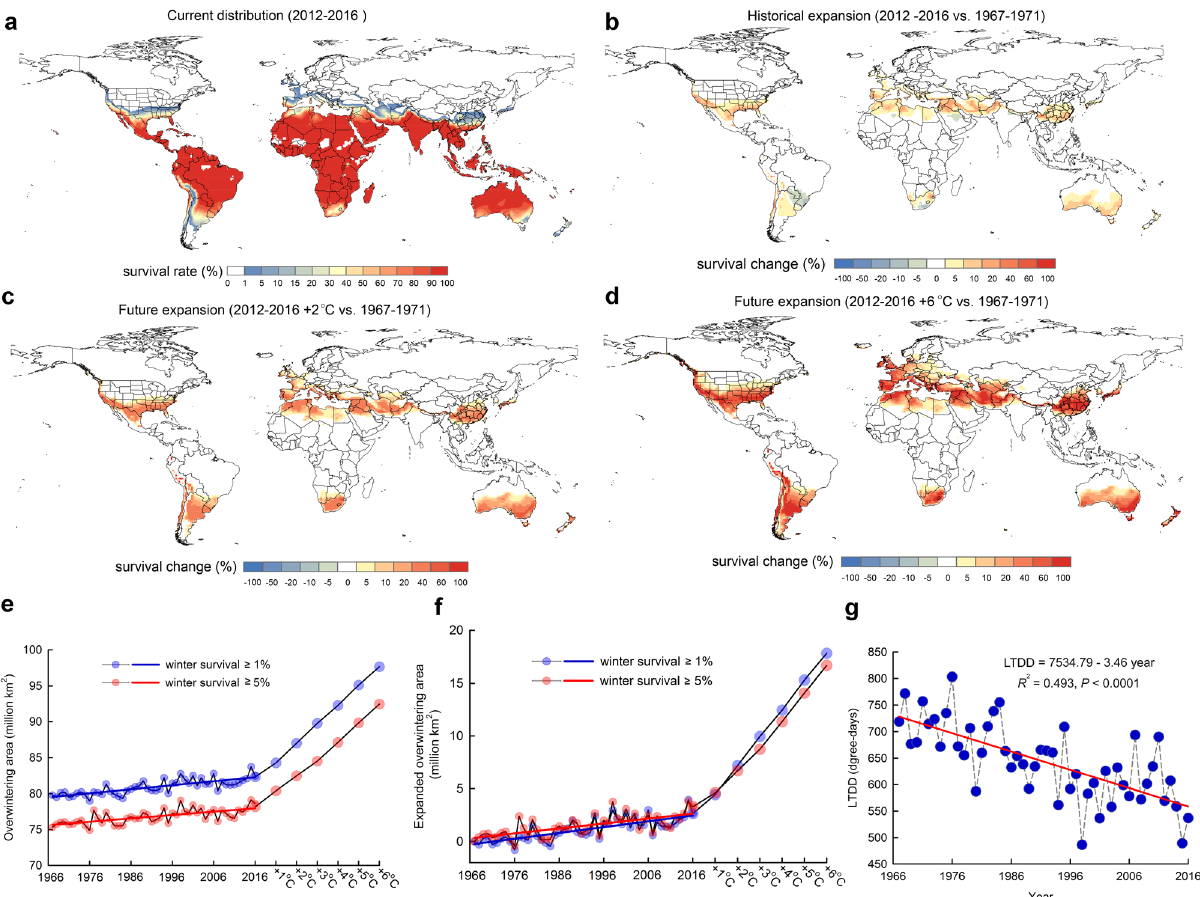
Fig. 3 Predicted global overwintering survival of the diamondback moth. a Mean distribution of winter survival in the present 5 years. b Changes in winter survival over the past 50 years. c , d Changes in winter survival for future climate scenarios with a predicted + 2 °C or + 6 °C increase in mean temperatures. e Predicted global overwintering land area, and f expanded overwintering area at given past and possible future warming scenarios. g Global annual dynamics of low-temperature degree-days (LTDD) in the overwintering marginal belt. In the tendency line, R 2 indicates the variability explained by the regression line. P value was calculated using two-sided Fisher ’ s test. All predictions are based on the fi eld validated LTDD-dependent survival model. Source data are provided as a Source data fi